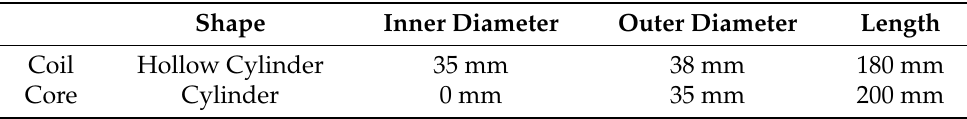
Figure 9. Experimental configuration for the dual receivers tracking system and the magnetic field sign-integration (MFSI) algorithm. Table 4. The geometric dimensions of the tracking